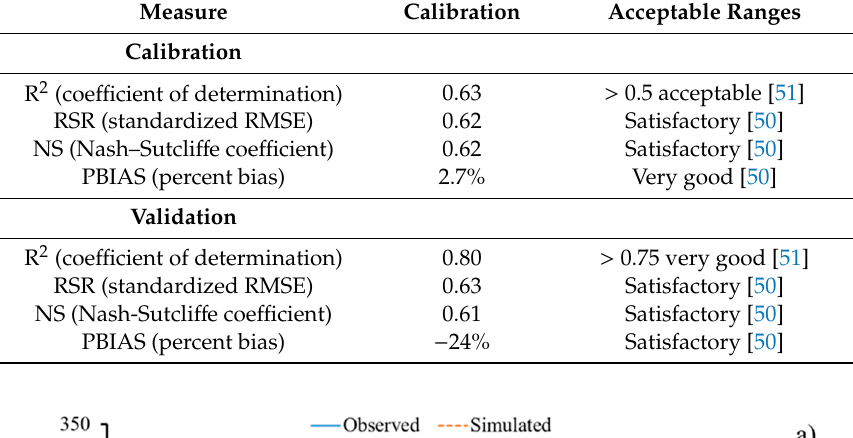
Table 3. Goodness-of-fit indicators for daily calibration between 1960 and 1999 and validation of streamflow between 2000 and 2008 in the Sabor river basin.